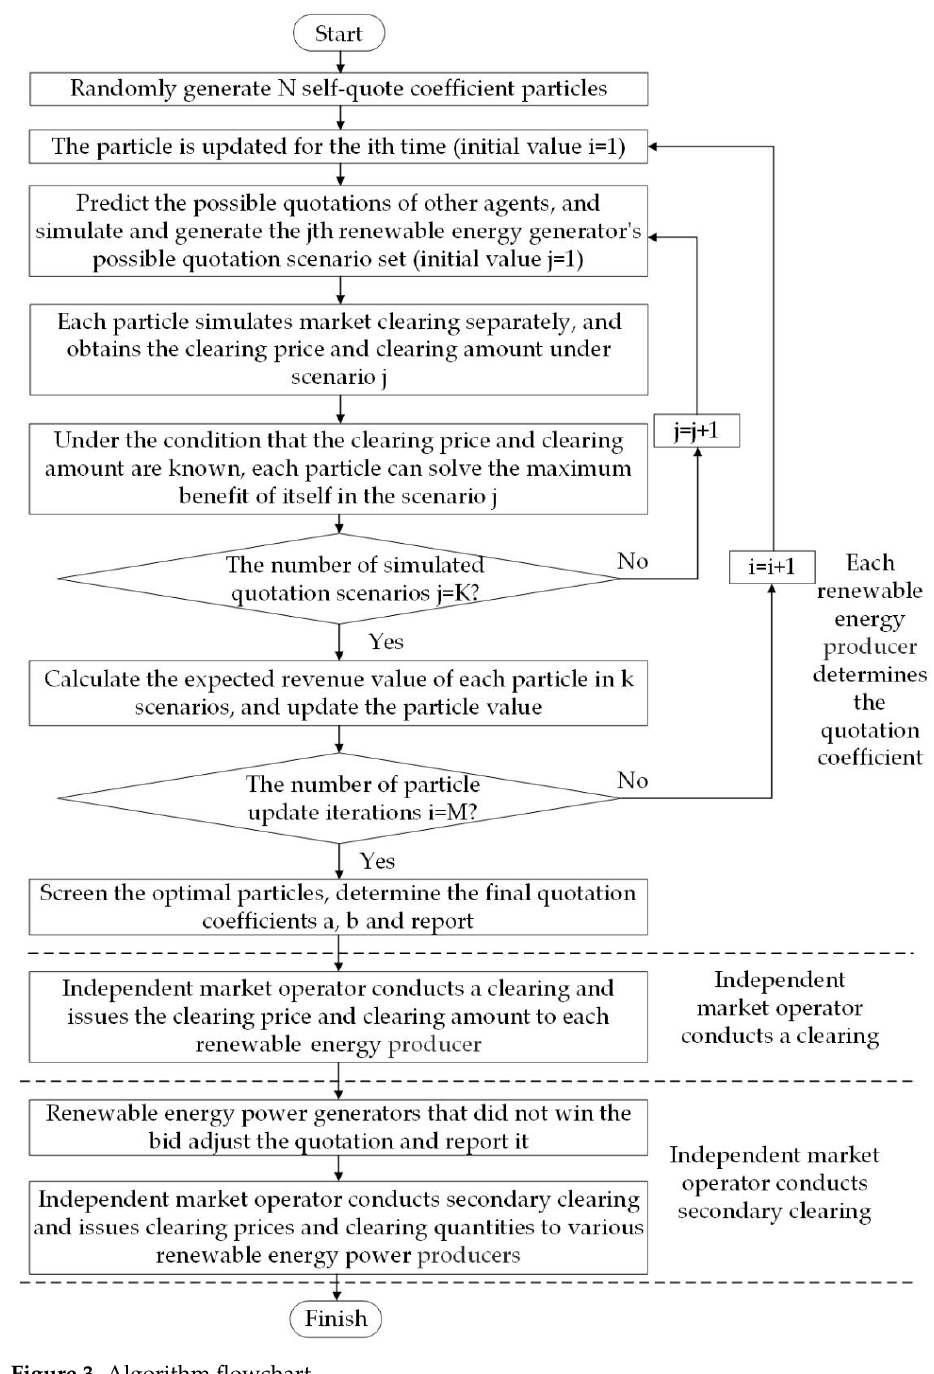
Figure 3. Algorithm flowchart.